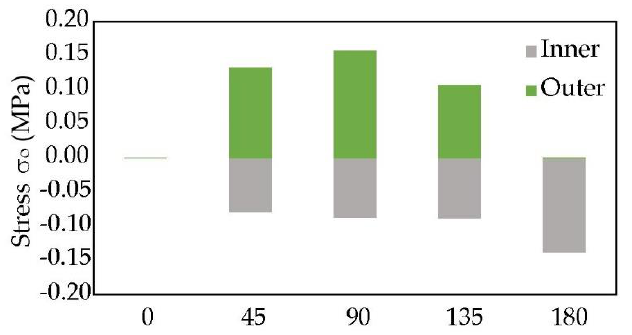
Figure 20. Stress during short-circuit (upper turns).